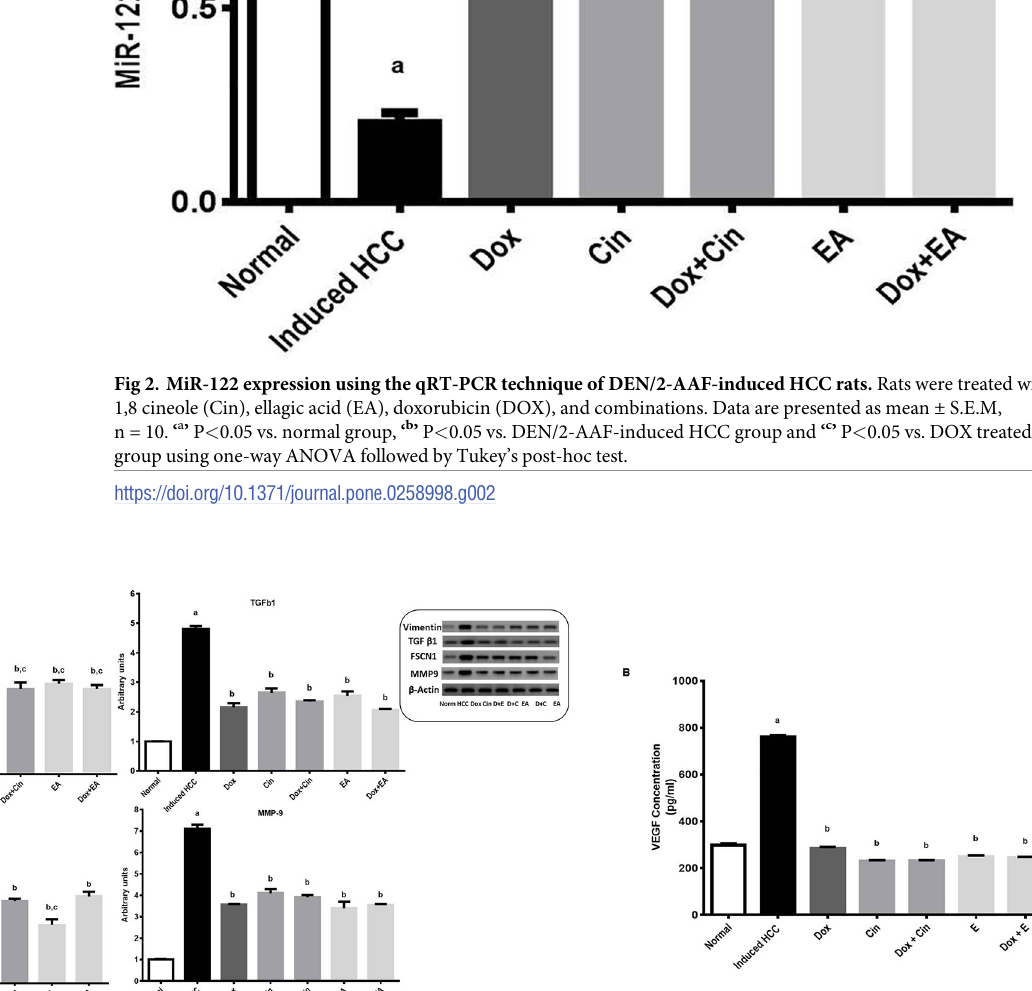
PLOS ONE | https://doi.org/10.1371/journal.pone.0258998 January 26,